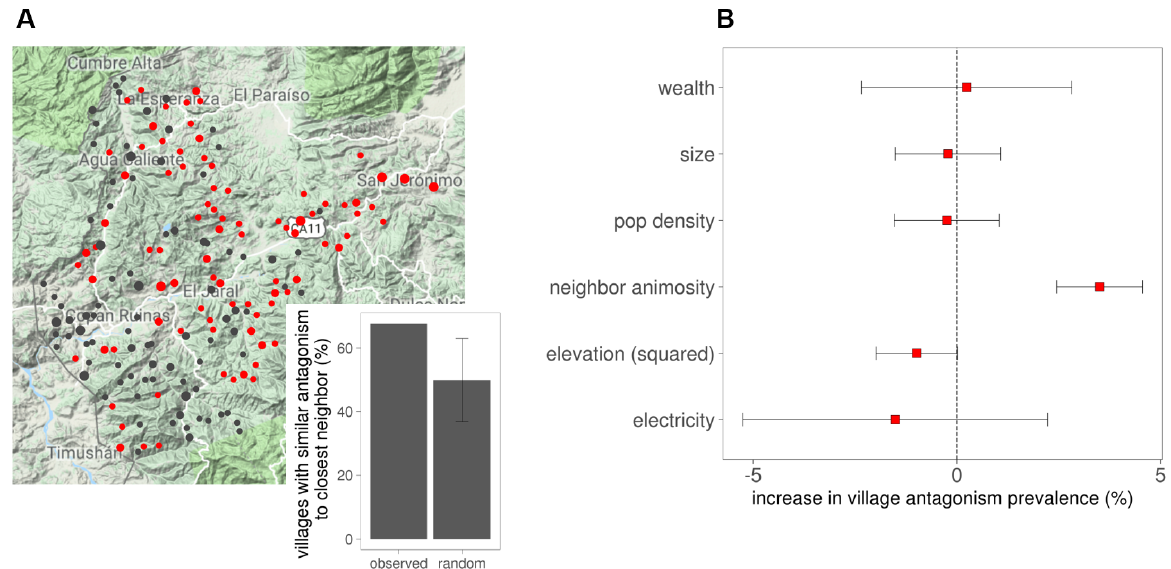
Figure 6: Analysis of village-level antagonism prevalence. (A) Topographical map of villages by size and prevalence of antagonism (N = 176 villages). Colors represent the prevalence of antagonism (ratio of negative ties to positive-plus-negative ties; red = higher than median, and black = lower than median; namely, 12.8 percent). Point sizes correspond to village size (from smallest to largest: < 150 people, 150–300 people, and > 300 people). The inset shows the observed percentage of villages (67.6 percent) that have the same antagonism prevalence (low or high) as their nearest geographic neighbor (“as the crow flies”) compared to a simulation in which antagonism levels are randomly permuted among villages (N = 1,000 simulations); the black bar represents a 99.5 percent confidence interval. There is significant geographic clustering of antagonism prevalence ( p < 0.005). (B) Percentage increase in antagonism prevalence ( x axis) based on bivariate models of village-level variables indicating how much a one–standard-deviation change in each of the variables shown ( y axis) is associated with an increased prevalence of antagonism from an ordinary least squares (OLS) estimate. A one-unit change is shown for factor variables (e.g., wealth and electricity). The estimate for elevation includes a squared term, and the change is calculated from an elevation centered on the maximum of the parabola, so only the effect of the squared term is shown. Black lines around estimates indicate 99.5 percent confidence intervals (see the online